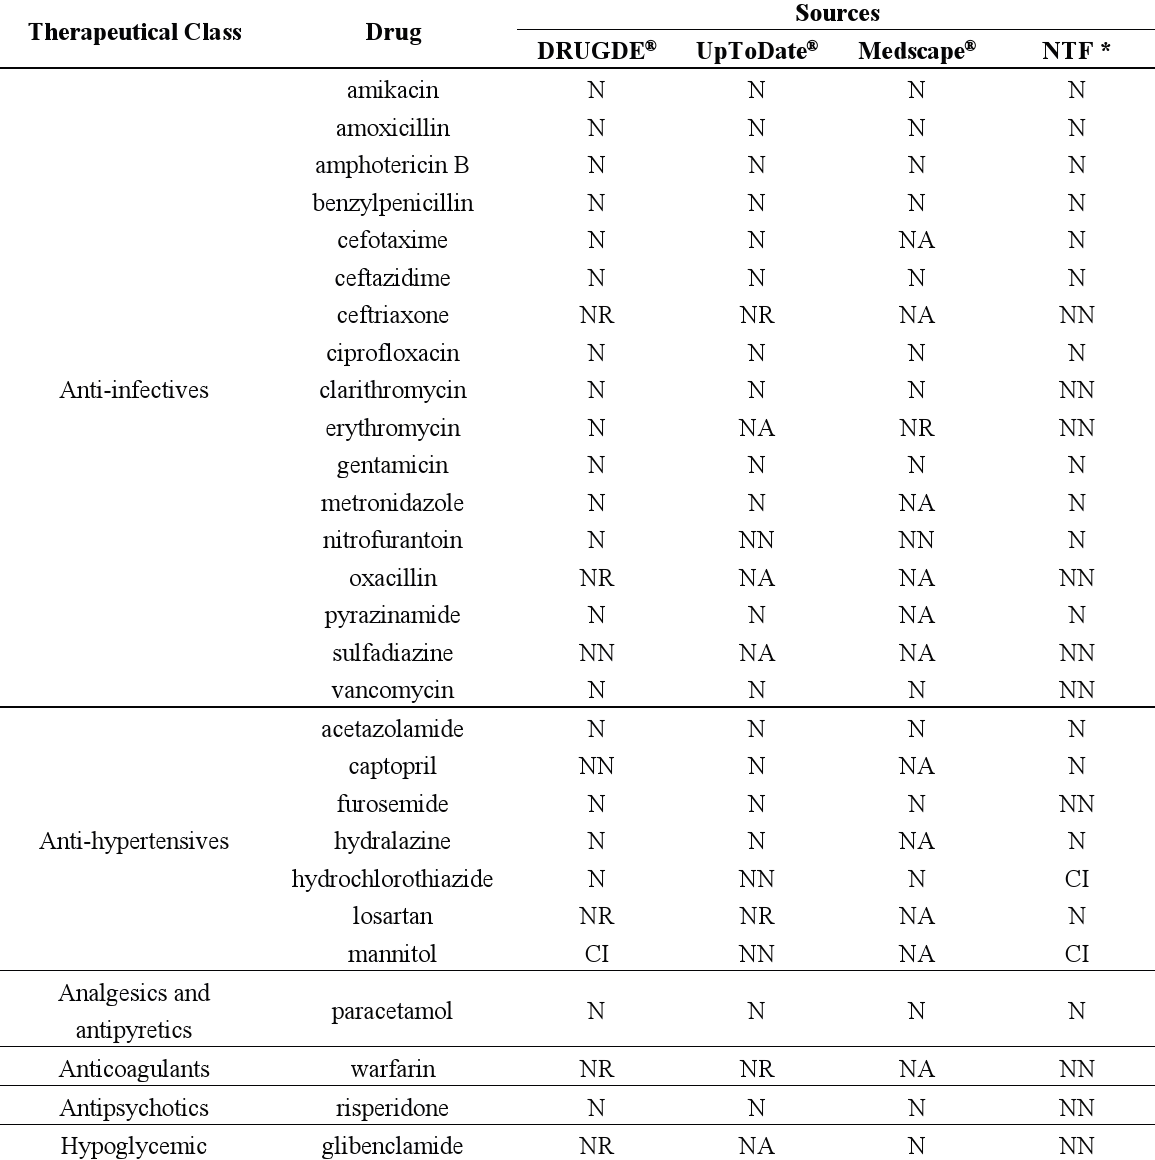
Table 4. Categories of dose adjustment recommendations for drugs commonly cited as nephrotoxic by the four information sources (n =